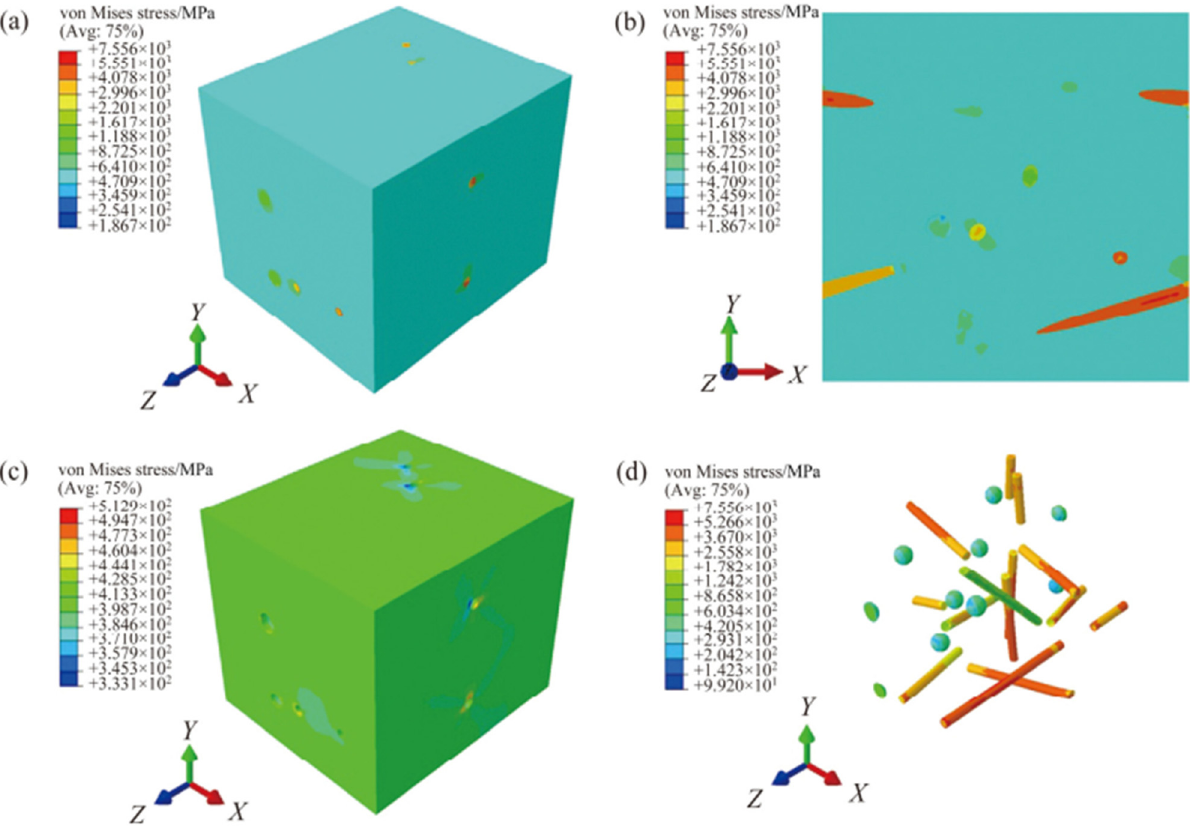
Figure 7: 3D numerical simulations of the dynamical tensile response of hybrid CNT/SiC - reinforced Mg - based composites considering interface cohesion at 100°C and strain rate of 1,000 s − 1 [ 186 ] . ( a ) 3D composite, ( b ) cross section of the composite, ( c ) Mg matrix, and ( d ) hybrid